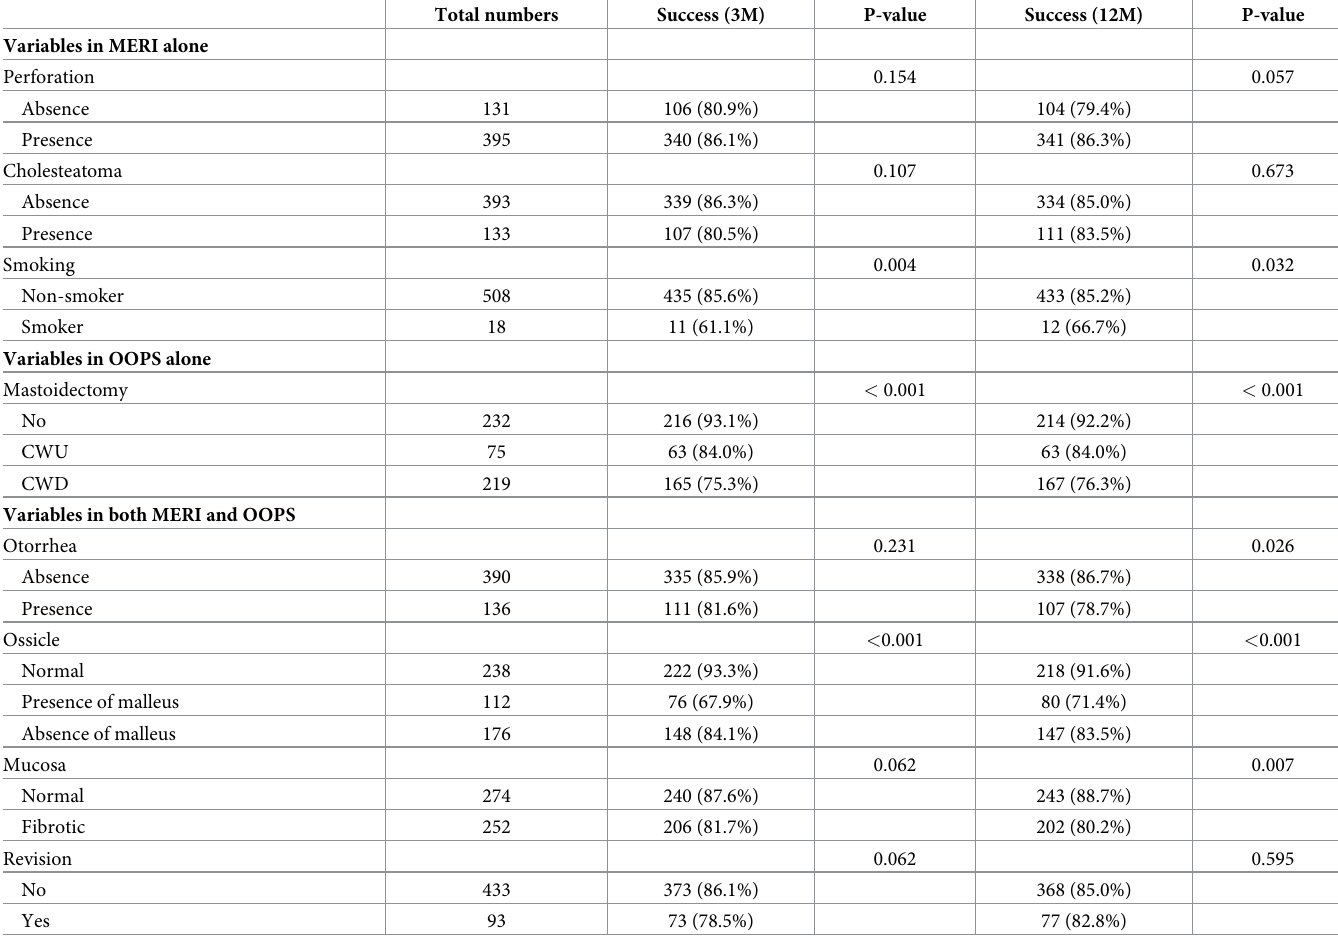
Table 3. Comparisons of success rate according variables in two